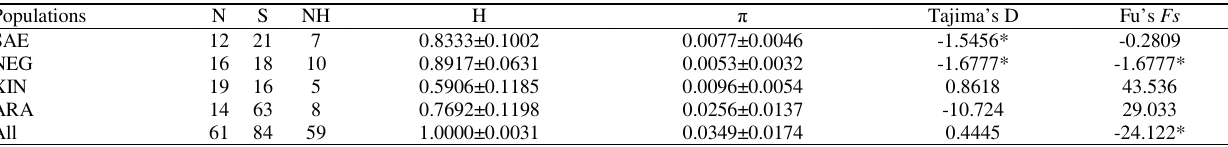
Table 3. Population genetics parameters of ATPase 6 estimated for Paratrygon aiereba . SAE= Solimões-Amazon River and Estuary, NEG= Negro River, XIN= Xingu River, ARA= Araguaia River. * Level of significance P < 0.005; N = Number of individuals; S = Number of polymorphic sites; NH = Number of Haplotypes; H = Gene diversity; (cid:3) = Nucleotide. * Level of significance P < 0.008, after Bonferroni